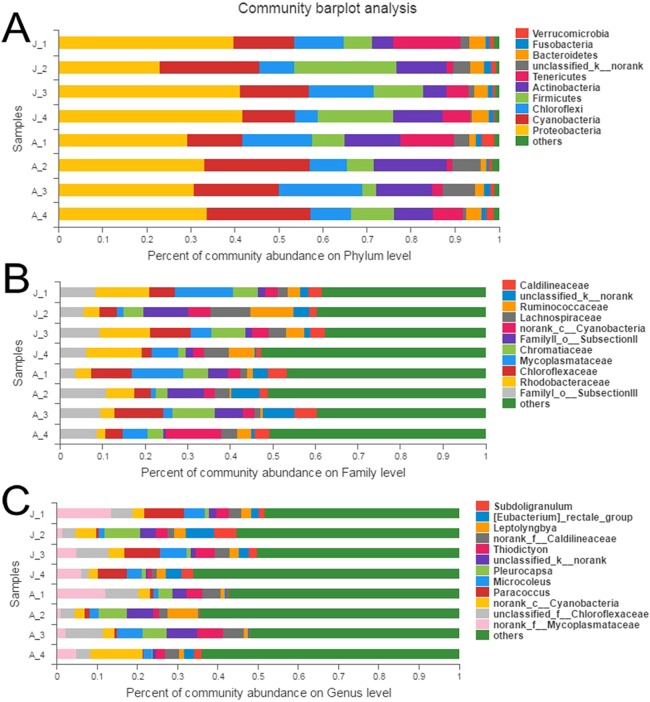
Relative abundance of bacterial communities in R. auricularia samples.(A) Phylum level, all remaining taxa with abundance <1% are summarized as other. (B) Family level (or the nearest identifiable phylogenetic level), all remaining taxa with abundance <5% are summarized as other. (C) Genus level (or the nearest identifiable phylogenetic level), all remaining taxa with abundance <5% are summarized as other.